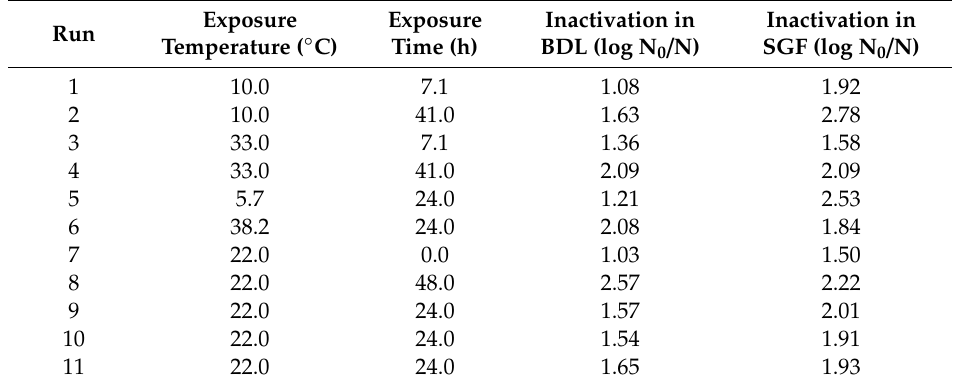
Table 1. Central composite rotatable design (CCRD) arrangement and decimal reduction of Salmonella Typhimurium in the Brazilian dry-cured loin (BDL) matrix and after 1 h exposure to simulated gastric fluid. Exposure Exposure Inactivation in Inactivation in Run Temperature ( ◦ C) Time (h) BDL (log N 0 / N) SGF (log N 0 /